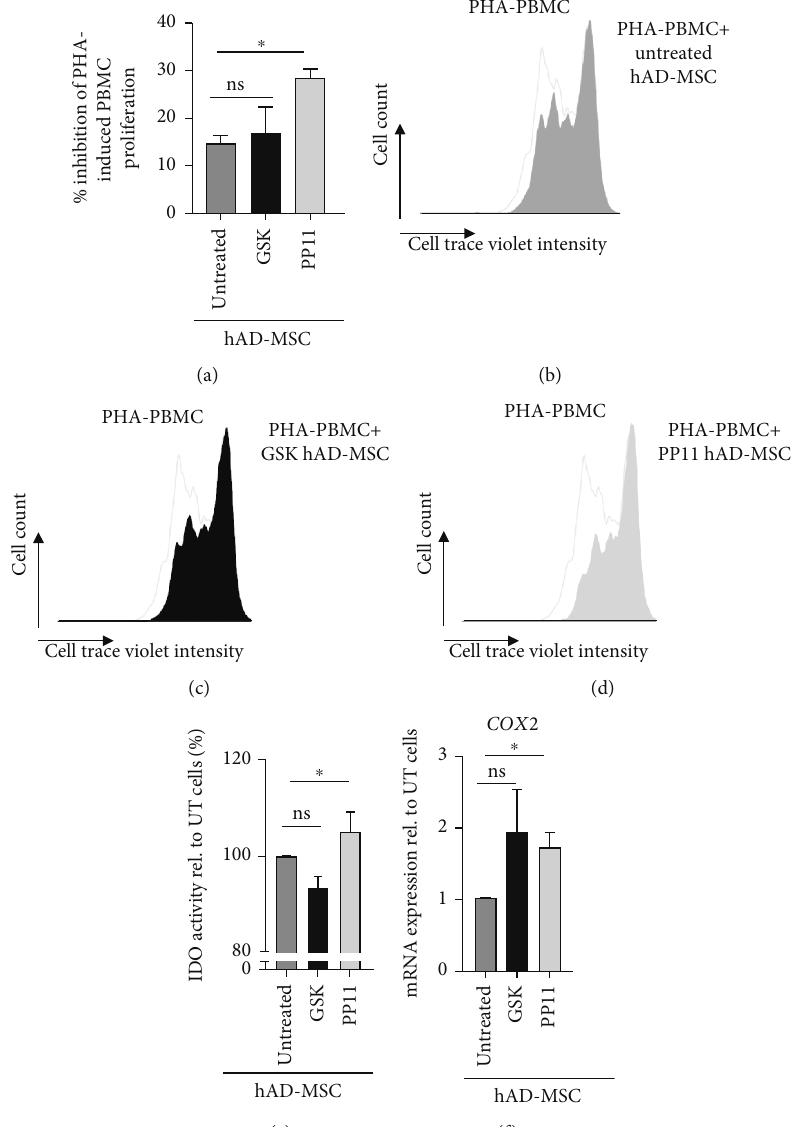
Figure 4: PP11 peptide signi fi cantly enhanced hAD-MSC immunosuppressive properties. (a – d) E ff ect of PPAR β / δ activity modulation on hAD-MSC immunosuppressive properties. PBMC stained with CTV were collected and analyzed by FACS to determine their proliferation rate (b – d) and calculate the percentage of inhibition (a) of PHA-activated PBMC cocultured in the presence of untreated hAD-MSC, hAD- MSC pretreated with GSK3787 (GSK hAD-MSC), or hAD-MSC pretreated with PP11 (PP11 hAD-MSC). (e, f) Impact of PPAR β / δ inactivation on immunomodulatory mediators. (e) IDO activity determined by a spectrophotometric assay for kynurenine in supernatant of cocultured hAD-MSC:PBMC. Nontreated (Untreated), GSK3787 (GSK), or PP11- (PP11-) pretreated hAD-MSC were cocultured with PHA-activated PBMC for 96 h. The kynurenine concentration in the presence of pretreated cells is expressed relative to that measured in the presence of untreated cells (%). (f) COX2 mRNA expression level in hAD-MSC was pretreated either with GSK3787 (GSK) or PP11 peptide (PP11), compared to untreated hAD-MSC. COX2 expression level was normalized to housekeeping gene ( RPS9 ) expression. mRNA expression in treated cells was standardized to expression in untreated hAD-MSC, and results are expressed using the 2 − ΔΔ Ct method. The results for proliferation inhibition were obtained with hAD-MSC from 4 donors ( N = 4 ). The statistical analysis was performed using the Mann – Whitney U test. Statistical signi fi cance was noted as ns for p > 0 : 05 and ∗ for p < 0 : 05 . The results for IDO activity were obtained with hAD-MSC from 3 donors ( N = 3 ) on 2 independent experiments. The statistical analysis was performed using the Wilcoxon test. Statistical signi fi cance was noted as ns for p > 0 : 05 and ∗ for p < 0 : 05 . The results for COX2 expression were obtained with hAD-MSC from 3 donors ( N = 3 ) on 2 independent experiments. The statistical analysis was performed using the Mann – Whitney U test. Statistical signi fi cance was noted as ns for p > 0 : 05 and ∗ for p < 0 : 05